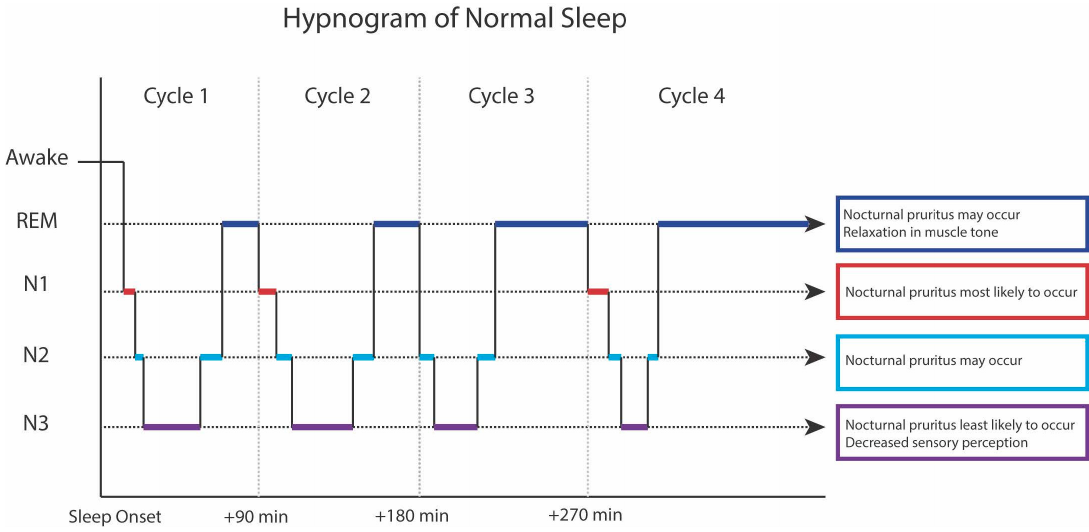
Figure 1. Hypnogram of normal sleep.